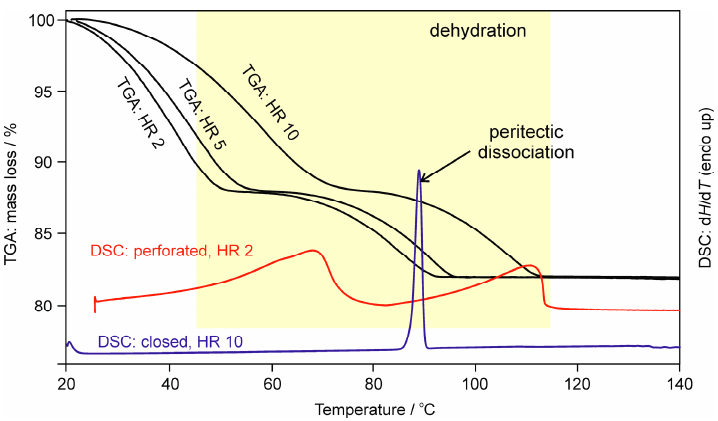
Figure 4. DSC and TGA thermograms of 2-Hy1 . Numbers correspond to heating rates in °C min − 1 .